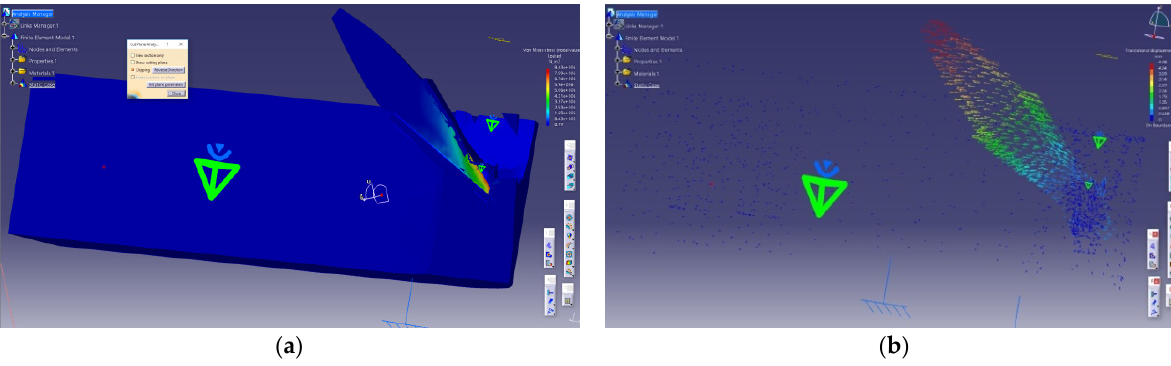
Figure 4. Lingualization of the LCI using a 1 N force: ( a ) von Mises tensions, 66% HBL; ( b ) tooth movement, 66% HBL.